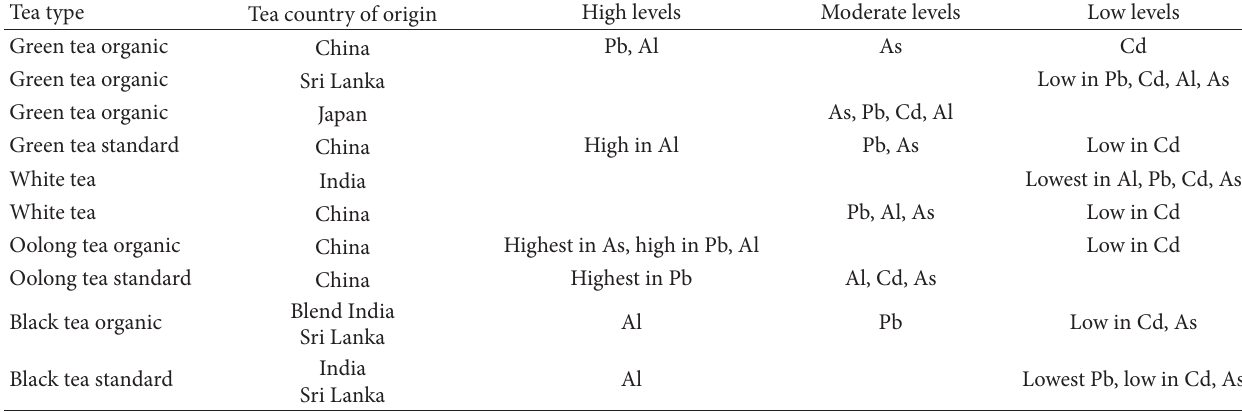
Table 4: Toxicant (heavy metal) levels according to country of